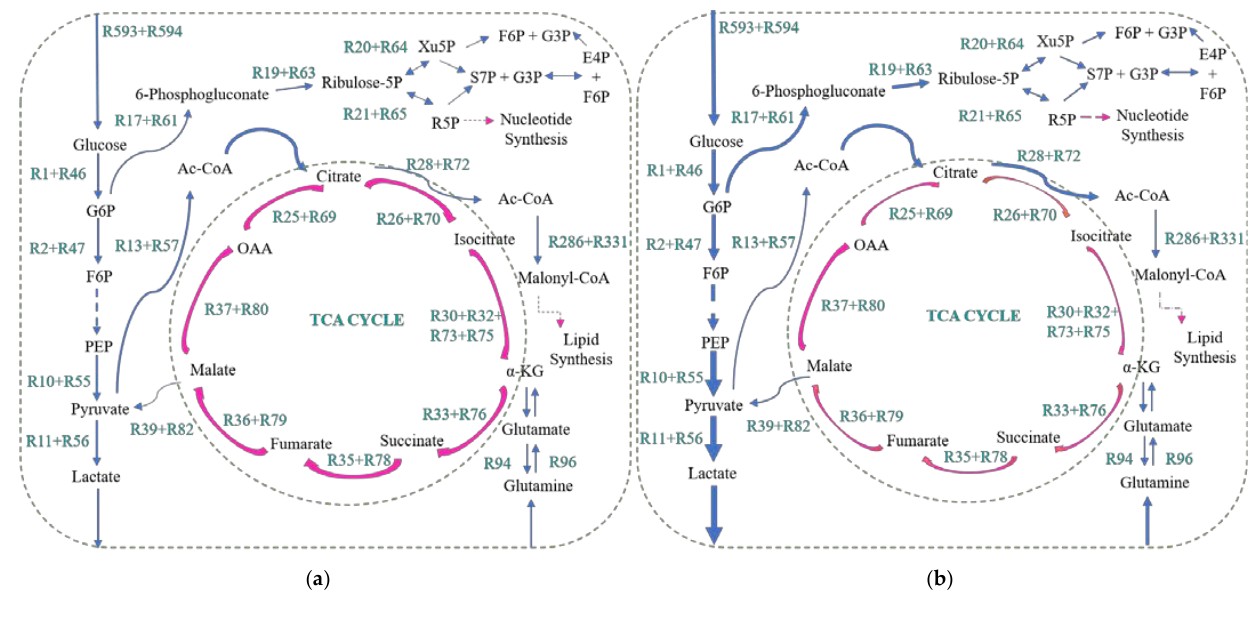
Figure 1. ( a ) Modeling healthy and ( b ) MB models. Low-flux and high-flux reactions are shown in thinner and thicker arrow, respectively. In addition to glycolysis, pentose phosphate pathway (PPP), tricarboxylic acid (TCA) cycle, flux change in other pathways for both models and corresponding reactions for reaction IDs are available in FBA results section of Supplementary Material S2. Table 1. The comparison of MB-specific models results with healthy model and experimental (exp.)